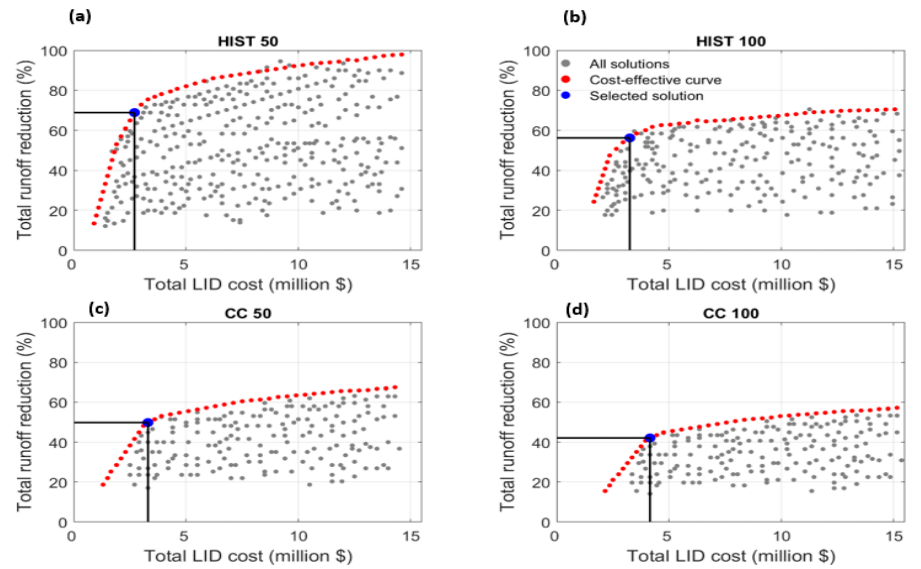
Figure 9. Reduction of total runoff versus LID implementation costs under the four storm scenarios: ( a ) HIST 50, ( b ) HIST 100, ( c ) CC 50, and ( d ) CC 100 .